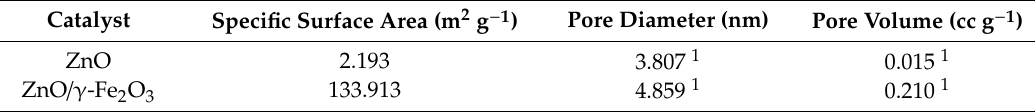
Table 1. Specific surface area and porosity distribution of ZnO flower-like and ZnO/γ-Fe 2 O 3 nanocomposite catalysts.